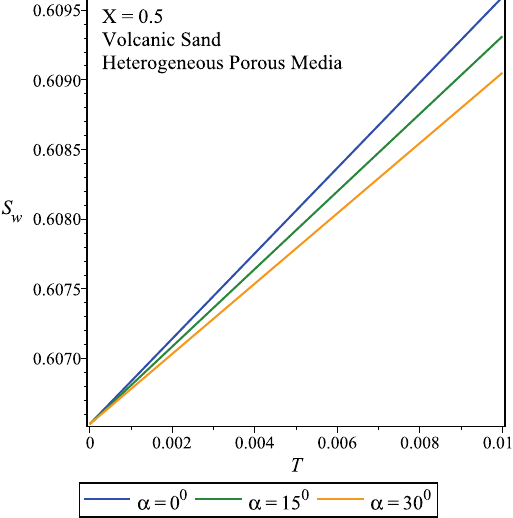
Fig. 2: Comparison of saturation vs. dimensionless times for differ-